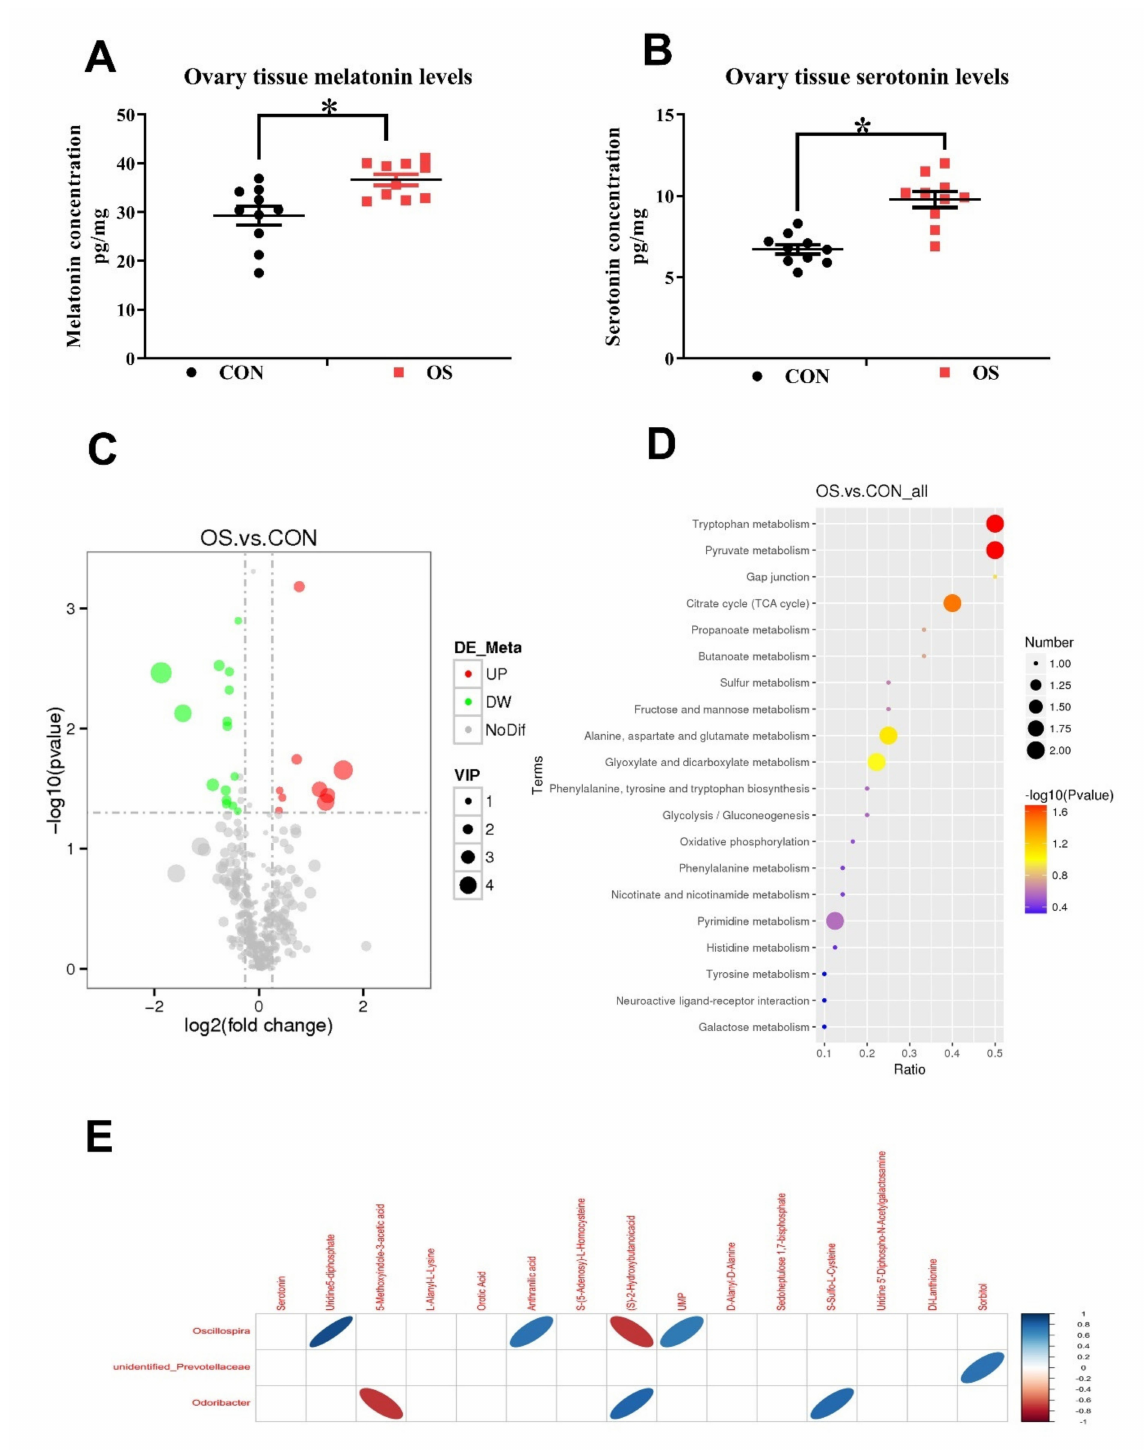
Figure 8. Oxidative stress (induced by tBHP) reduced increased serotonin and melatonin levels in the ovary and changed body amino acid biosynthesis and metabolism. ( A ) Ovarian tissue melatonin levels. ( B ) Ovarian tissue serotonin levels. ( C ) Description of the different metabolites between OS and CON group by volcano plot. ( D ) KEGG pathway enrichment of target metabolites. ( E ) Spearsman Correlationship between metabolites and microbiota. Statistical significance was evaluated by the Student’s t -test, * p <